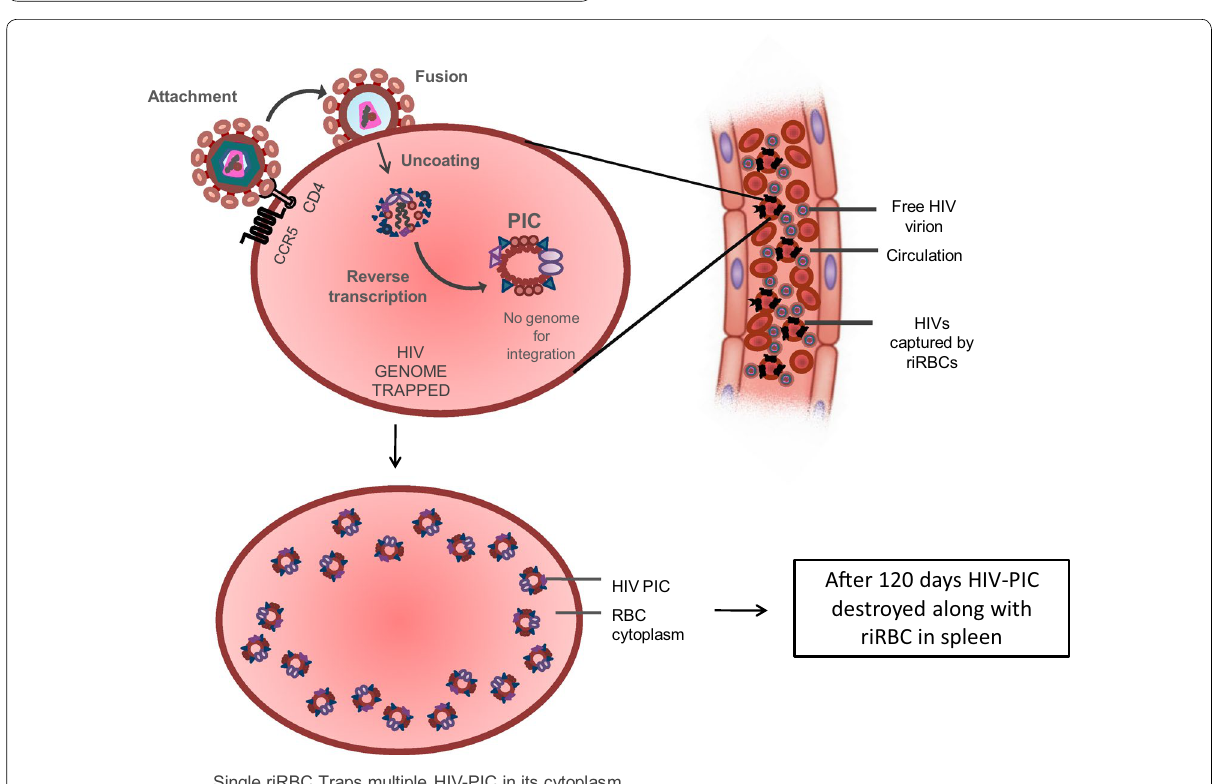
Fig. 4 Trapping HIVs within riRBC and destroying them. Once in blood, the riRBCs will engage to bind free HIV particles by the interaction of viral glycoproteins gp 120 and gp 41 with its membrane embedded CD4, CCR5 and CXCR4. After attachment fusion of viral and riRBC membrane will result in uncoating of viral core contents within cell cytoplasm leading to reverse transcription using its own transcriptase to form PIC. A single riRBC will be able to trap numerous HIV-PIC. However, once PIC formed it will remain inert as it will hardly find any genome to integrate and finally will be destroyed along with aged riRBC in spleen. HIVs human immunodeficiency viruses, CD4 cluster of differentiation 4, CCR5 C-C chemokine receptor type 5, riRBC receptor integrated red blood corpuscle, PIC pre integration